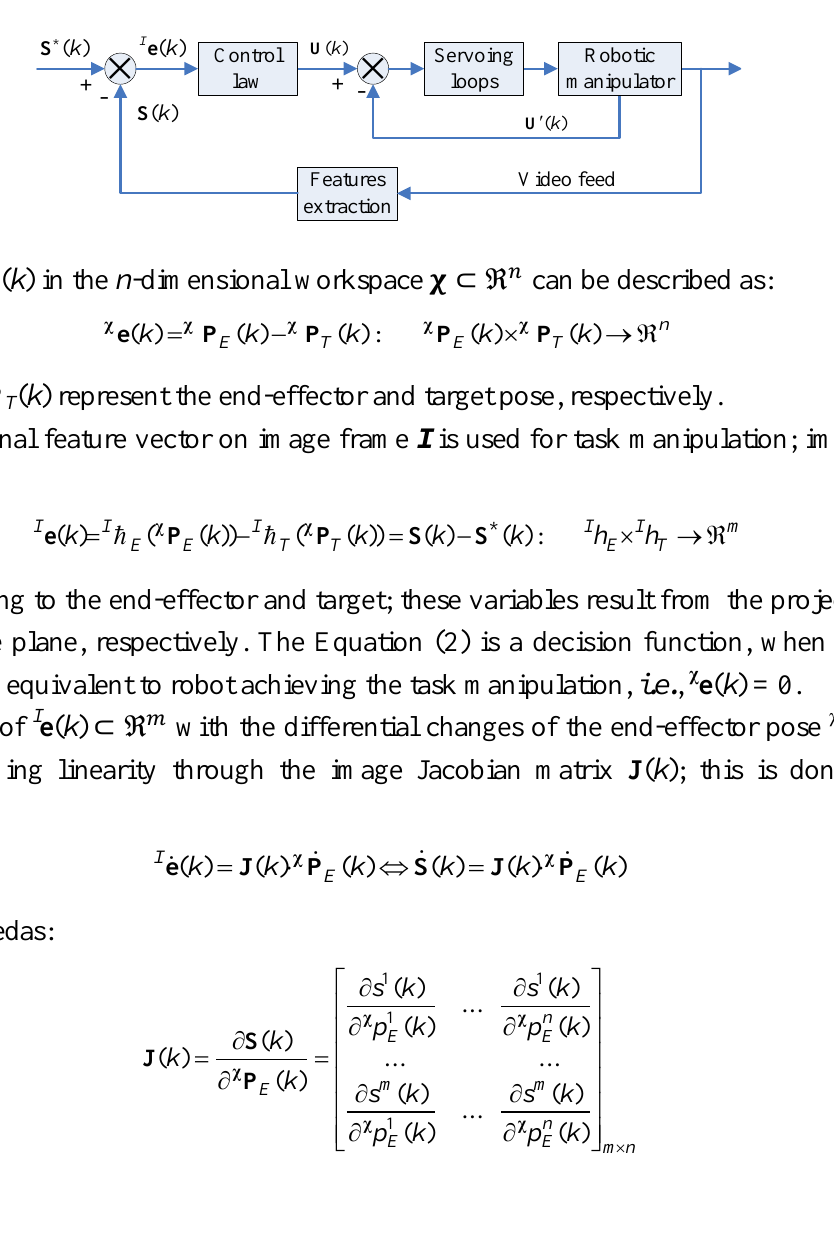
Figure 1. The general structure of uncalibrated model-independent VS